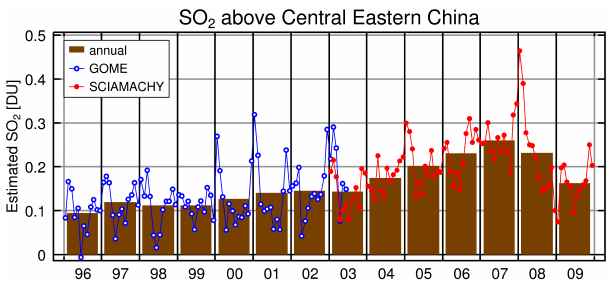
Fig. 9. Monthly (lines) and annual average (bars) estimated sul- fur dioxide column over Eastern China as estimated from satellite measurements (Gottwaldov et al.,